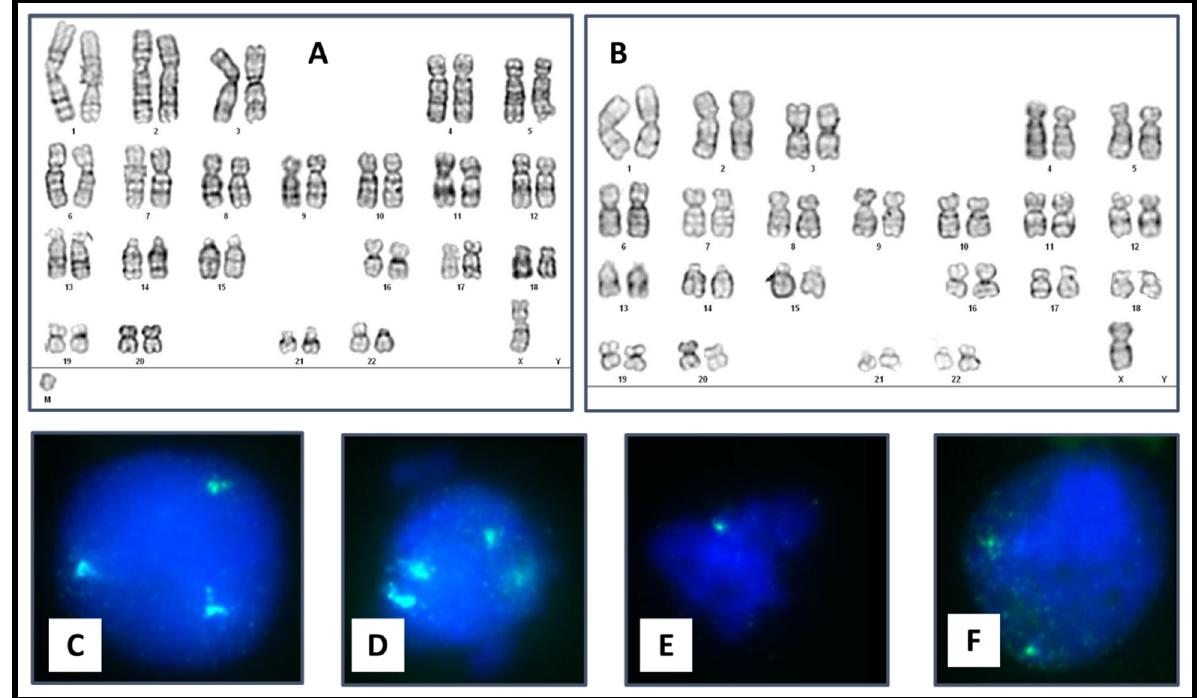
Figure 2. Cytogenetic findings in the proband from peripheral blood (PB) and buccal mucosa (BM). ( A ) PB karyotype 46,X,+mar. ( B ) PB Karyotype 45,X. ( C ) PB FISH with two blue signals (D18Z1) and a green one (DXZ1). ( D ) PB FISH with two blue signals (D18Z1) and two green signals (DXZ1). ( E ) BM FISH with a single green signal (DXZ1). ( F ) BM FISH with two green signals (DXZ1).